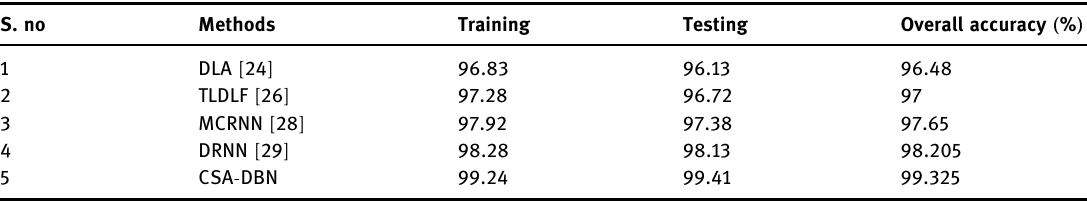
Table 3: F 1 - score